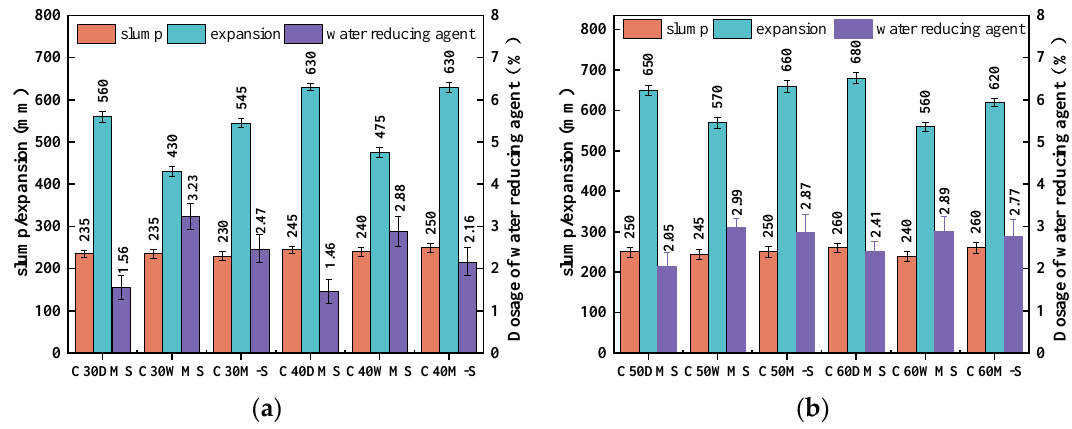
Figure 8. Workability of concrete mixtures of each group. ( a ) Workability of C30 and C40 strength grade. ( b ) Workability of C50 and C60 strength grades.